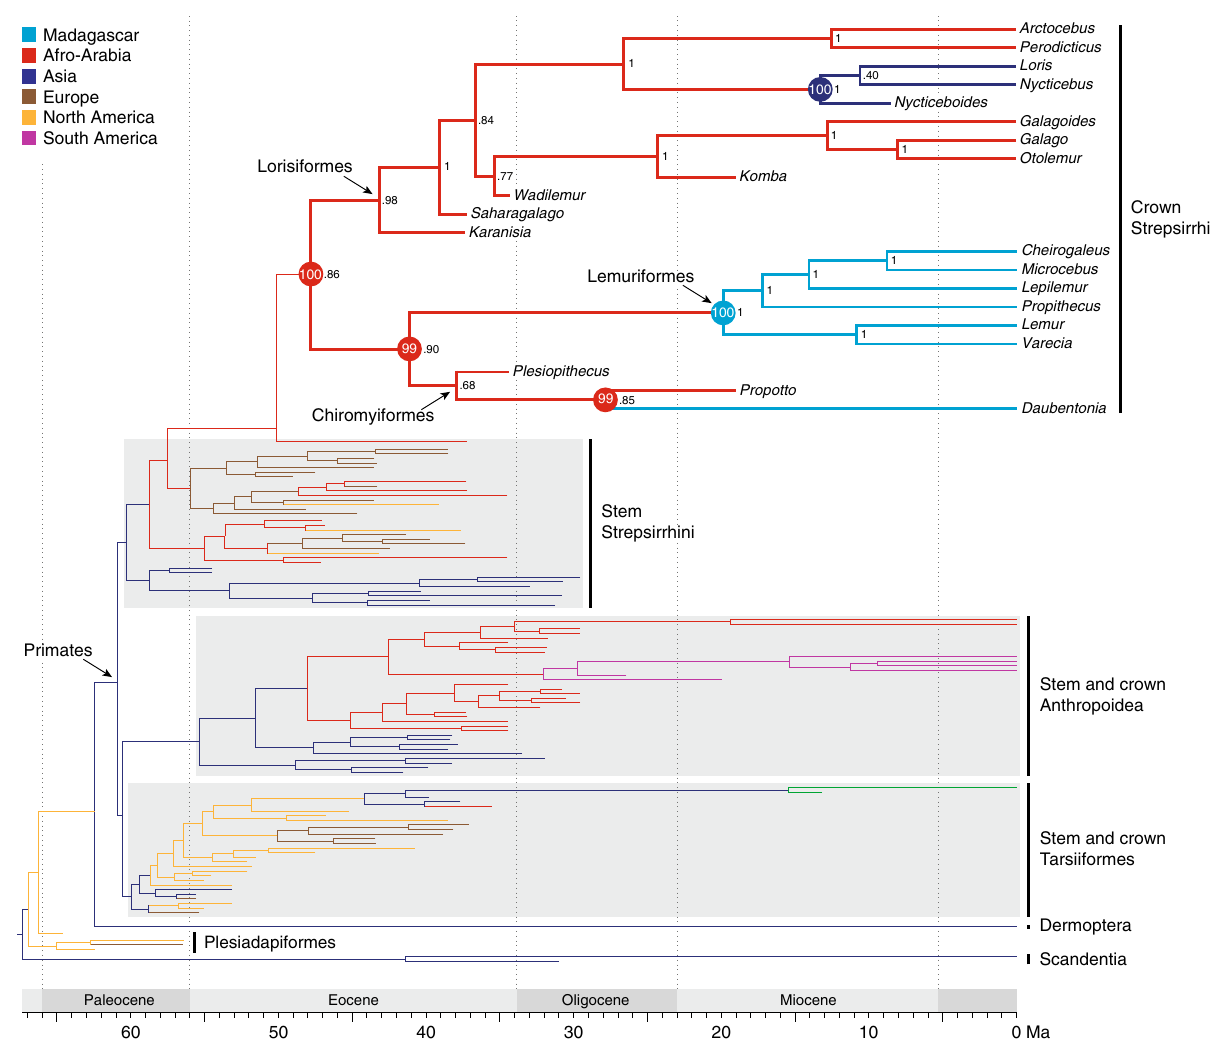
Fig. 6 Phylogenetic relationships and biogeography of living and extinct strepsirrhines. Time-scaled tree derived from Bayesian tip-dating analysis of the combined molecular and morphological dataset. Terminal branches are color coded according to continental biogeography, and internal branches are color coded according to Bayesian ancestral biogeographic analysis. Numerical values to the right of nodes represent clade support (posterior probabilities) and circled numbers at each strepsirrhine node represent the posterior probability of each biogeographic reconstruction. Complete time-scaled phylogenetic trees and biogeographic reconstructions are available at the Dryad Digital Repository associated with this study